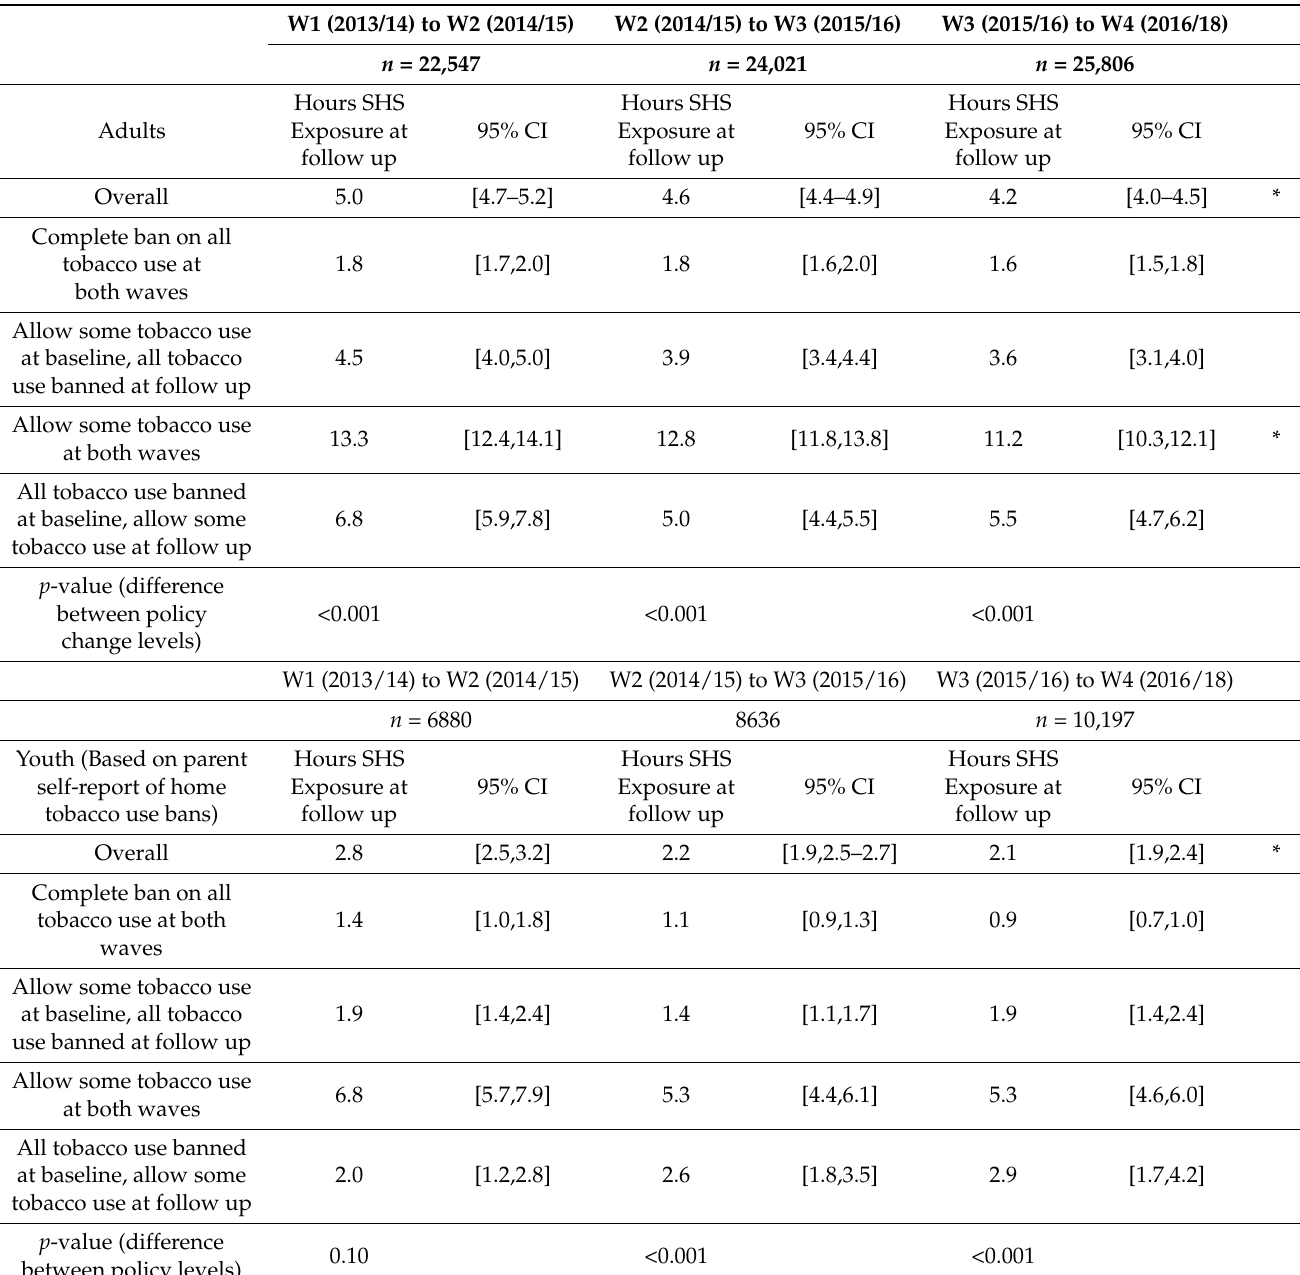
Table 4. Average hours of secondhand smoke (SHS) exposure in the past 7 days by home tobacco use policy change between survey